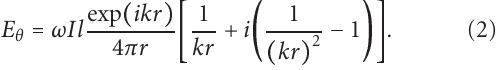
Figure 1: The geometry of a thin wire above layered